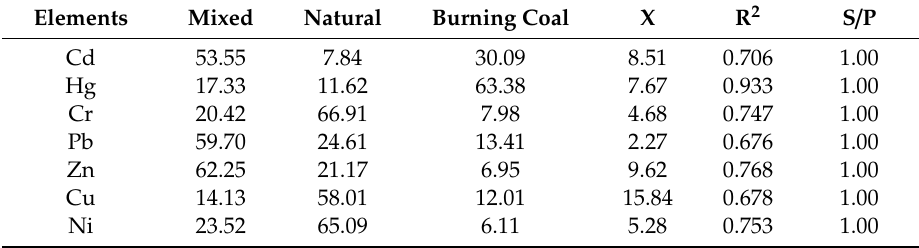
Table 4. Contribution (%) by pollution source to each heavy metal in Shijiazhuang street dust. Elements Mixed Natural Burning